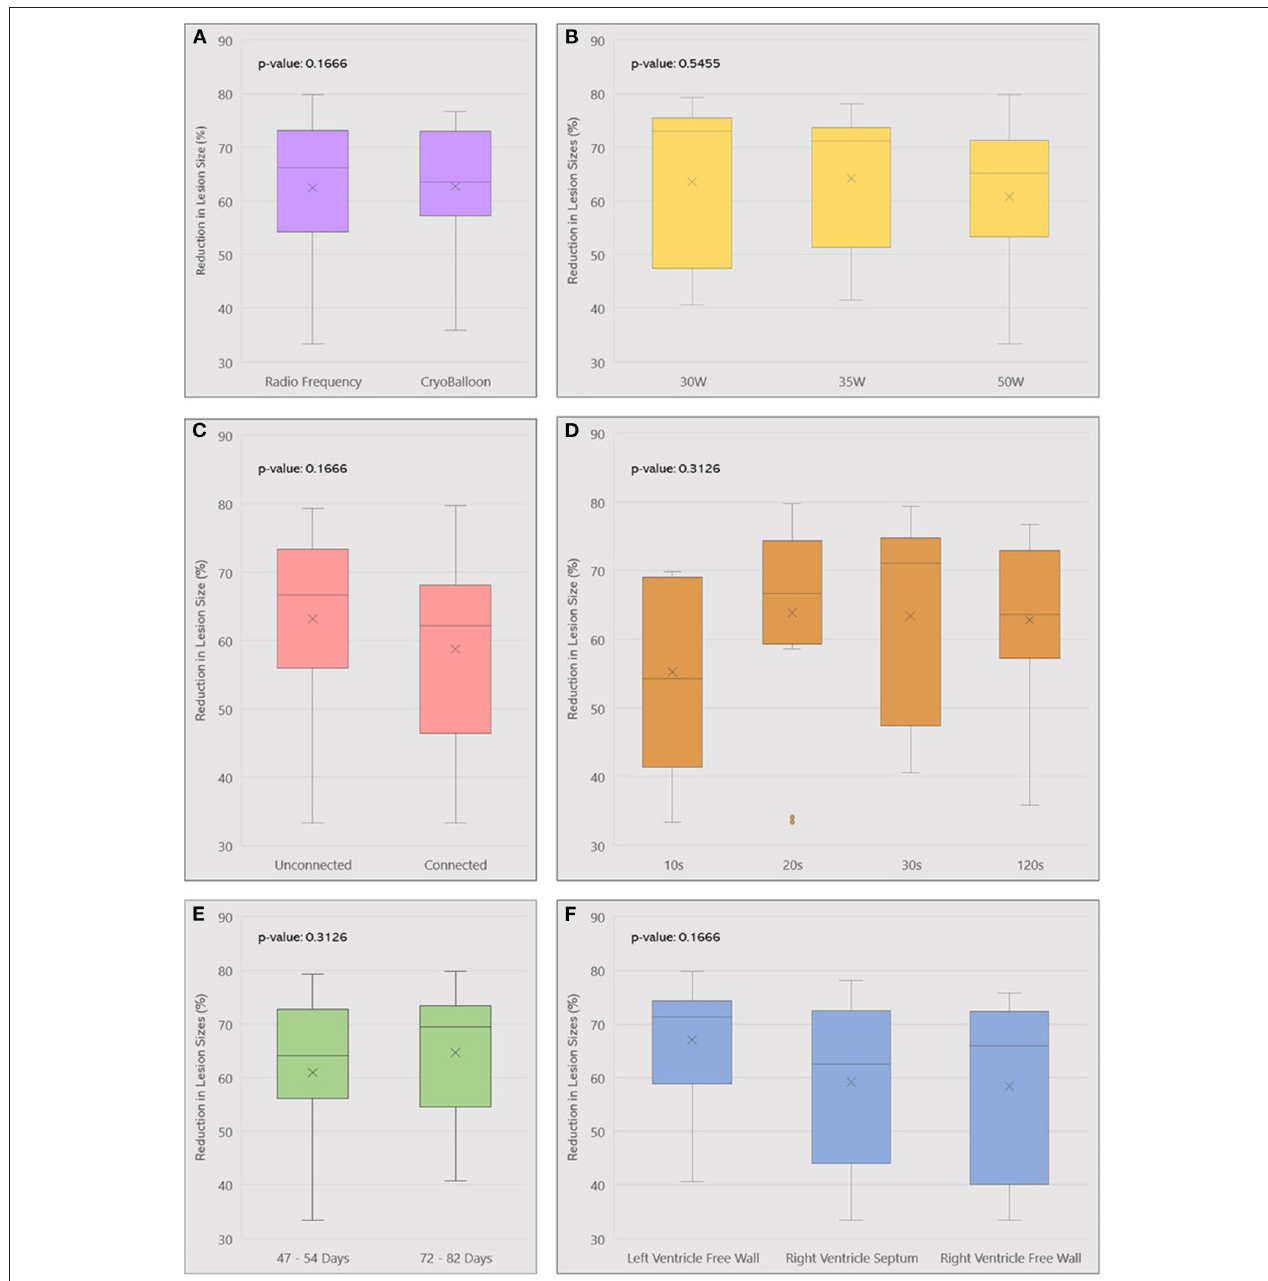
FIGURE 4 | Box plot summarizing lesion volume reduction across different ablation parameters used: ablation method (A) , Power (B) , Lesion contiguity (C) , Duration (D) , Follow-up (E) , and Location (F) . W, Watts; s, seconds.